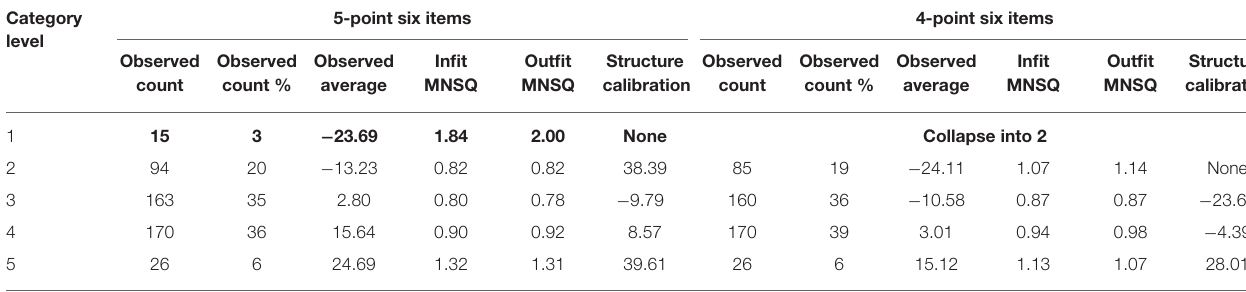
5-point six items